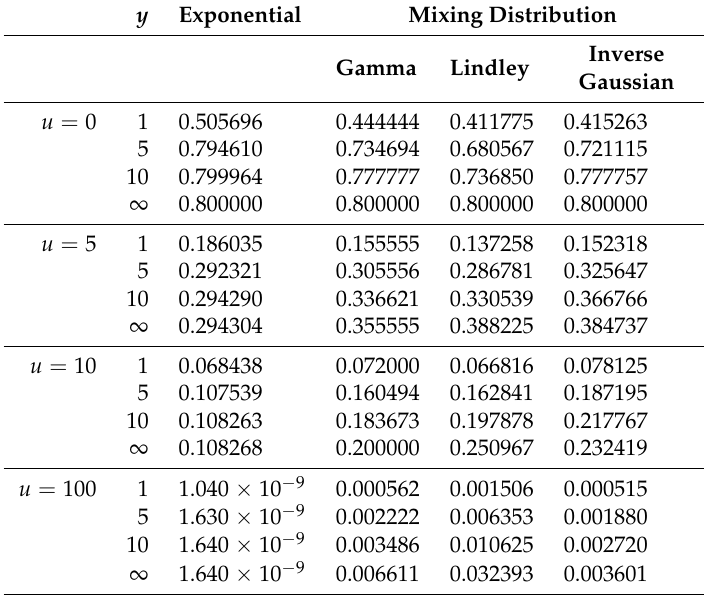
Table 5. Probabilities of severity of ruin with a premium loading factor, θ =